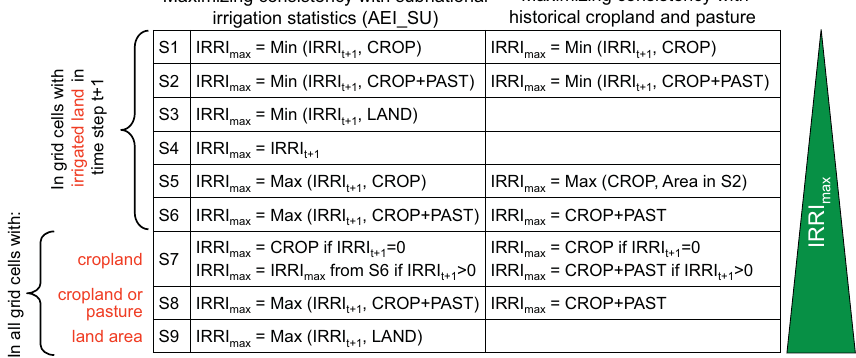
Figure 2. Illustration of the rules used to assign irrigated area to specific grid cells. The maximum irrigated area in each grid cell (IRRI max ) is calculated in steps S1–S9 depending on irrigated area assigned to the grid cell in the previous time step (IRRI t + 1 ), cropland extent in the current time step (CROP), pasture extent in the current time step (PAST) and total land in the grids cell (LAND). The assignment terminates, when the sum of IRRI max for all grids cells belonging to an administrative unit is greater than or equal to the irrigated area reported in the sub-national statistics for the administrative unit. Please note that the previous time step is t + 1 (and not t − 1) as the procedure is marching back in time. The downscaling procedure is described based on seven examples in Supplement S4.